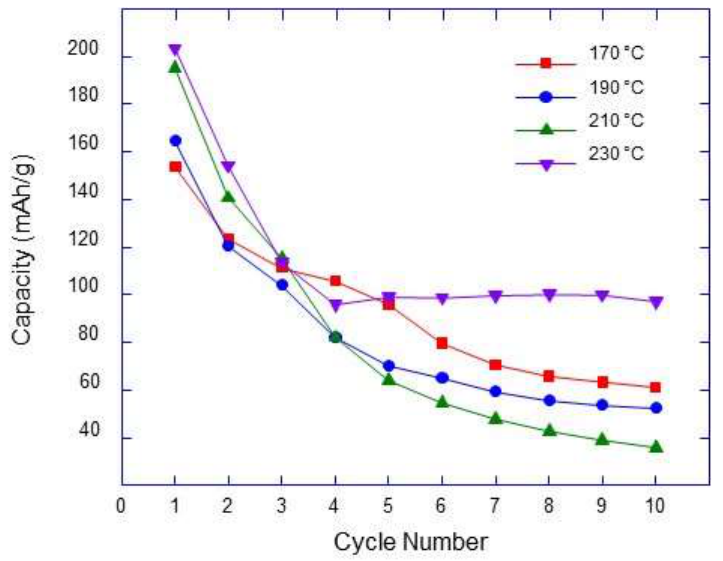
Figure 5. Cycling performance at a constant current rate (0.12 C) of TiO 2 powders prepared at the reported temperatures and employed as anode materials for LIBs.